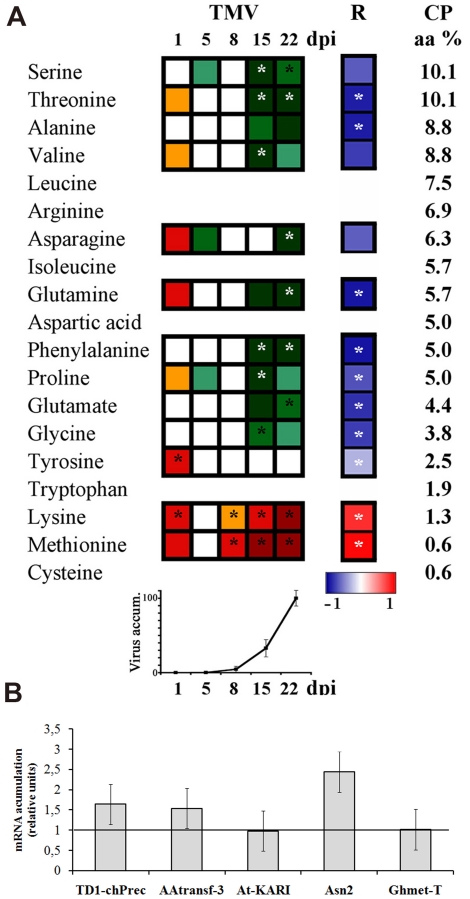
Relative abundance of free amino acids in TMV infected Plants.
A) Changes in the relative abundance of free amino acids between TMV-inoculated and control plants detected by GC-MS experiments (same data as Figure 2). Pearson correlation between CP and free amino acids levels was calculated and the correlation coefficients R are showed on a blue-red false color scale. Asterisks indicate statistically significant correlations (P<0.01). Amino acid composition of CP is listed as a percentage of abundance (aa %) and CP accumulation during virus infection is shown as line graphic. B) Relative mRNA accumulation of genes involved in amino acids synthesis detected by qPCR: TD1-chPrec = chloroplast threonine deaminase 1 precursor, AAAtransf3 = Branched-Chain Amino Acid Aminotransferase 3, AtKARI = similar to A. thaliana ketol-acid reductoisomerase, Asn2 = Asparagine Synthetase 2, GHmetT = Glycine Hydroxymethyltransferase.